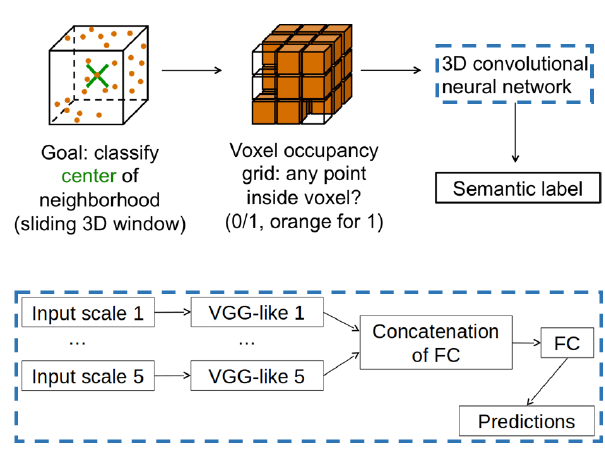
Figure 3: Our deep neural network